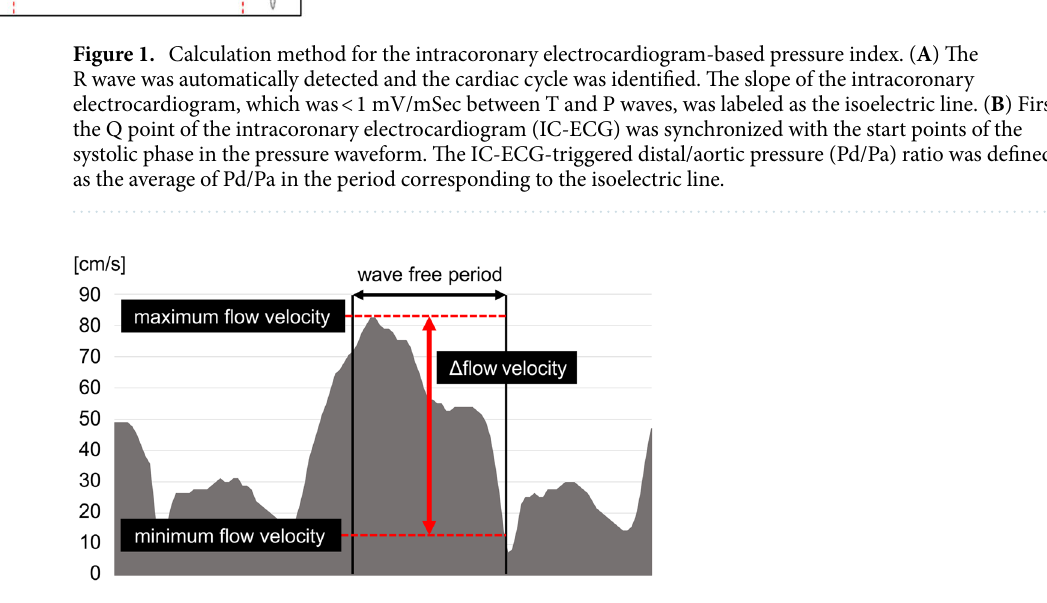
Figure 2. Definition of Δflow velocity. Differences between the minimum and the maximum flow velocity during the analysis interval of each index were defined as Δflow velocity. ΔPd/Pa and ΔResistance were similarly defined. Pd/Pa distal/aortic